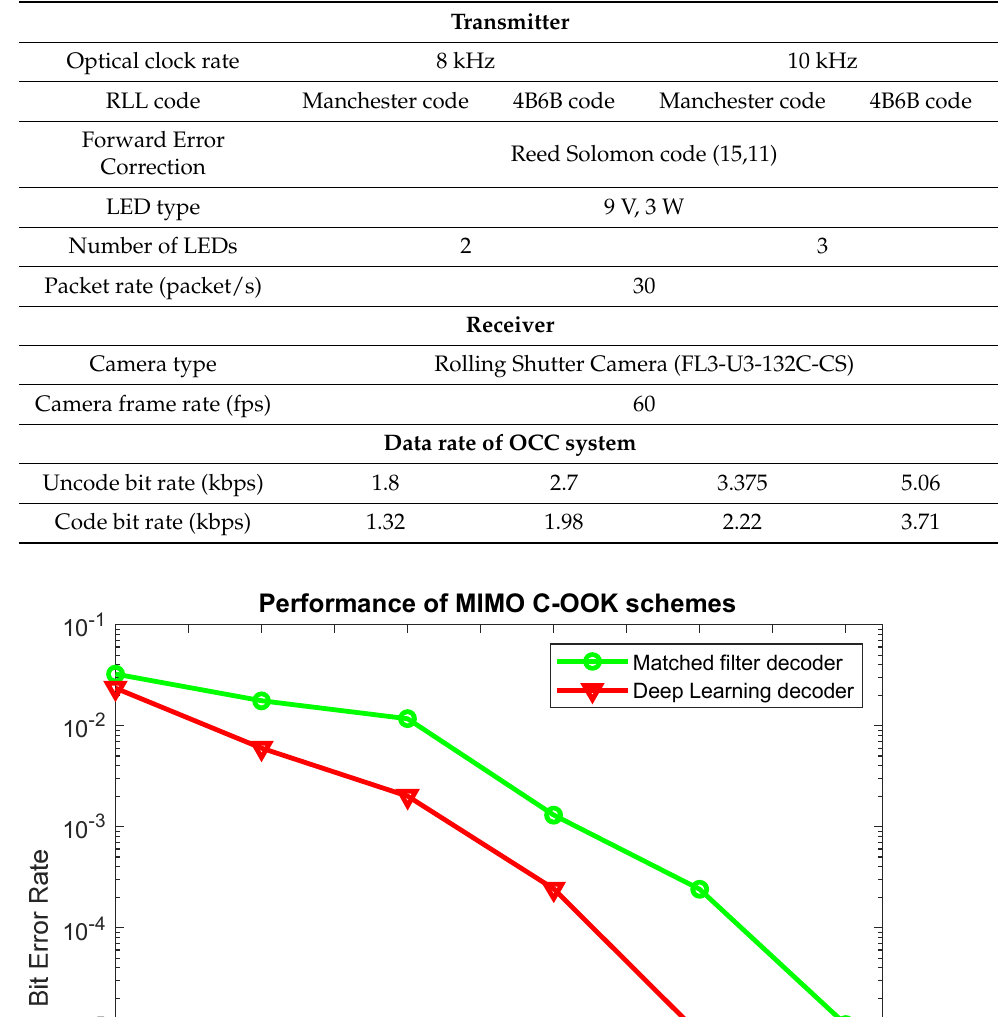
Table 1. The parameter characteristics of the proposed scheme.